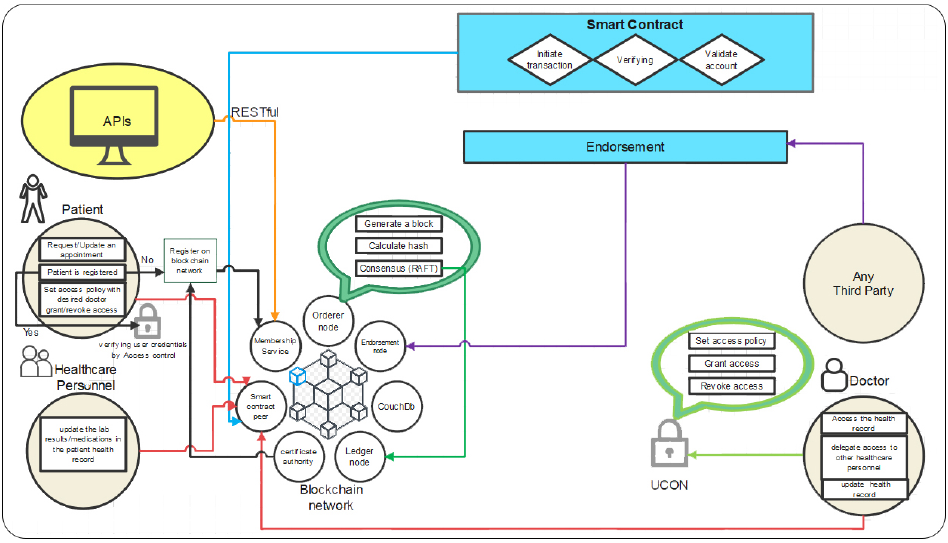
Figure 10. Smart contract and transaction over Hyperledger Fabric